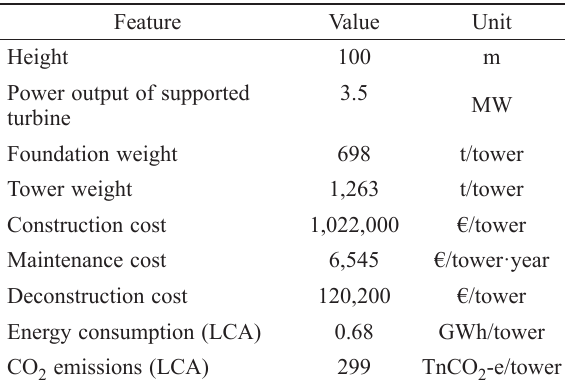
Table 2. Values of the main features of the proposed tripod tower (100 m height)